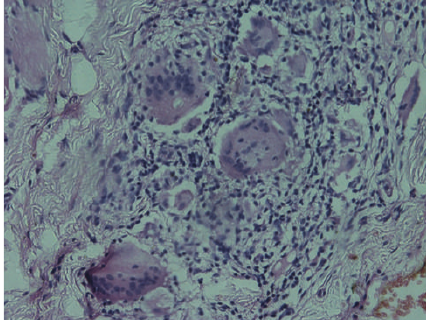
Figure 4: Pretreatment photograph of second patient showing diffuse swelling of upper